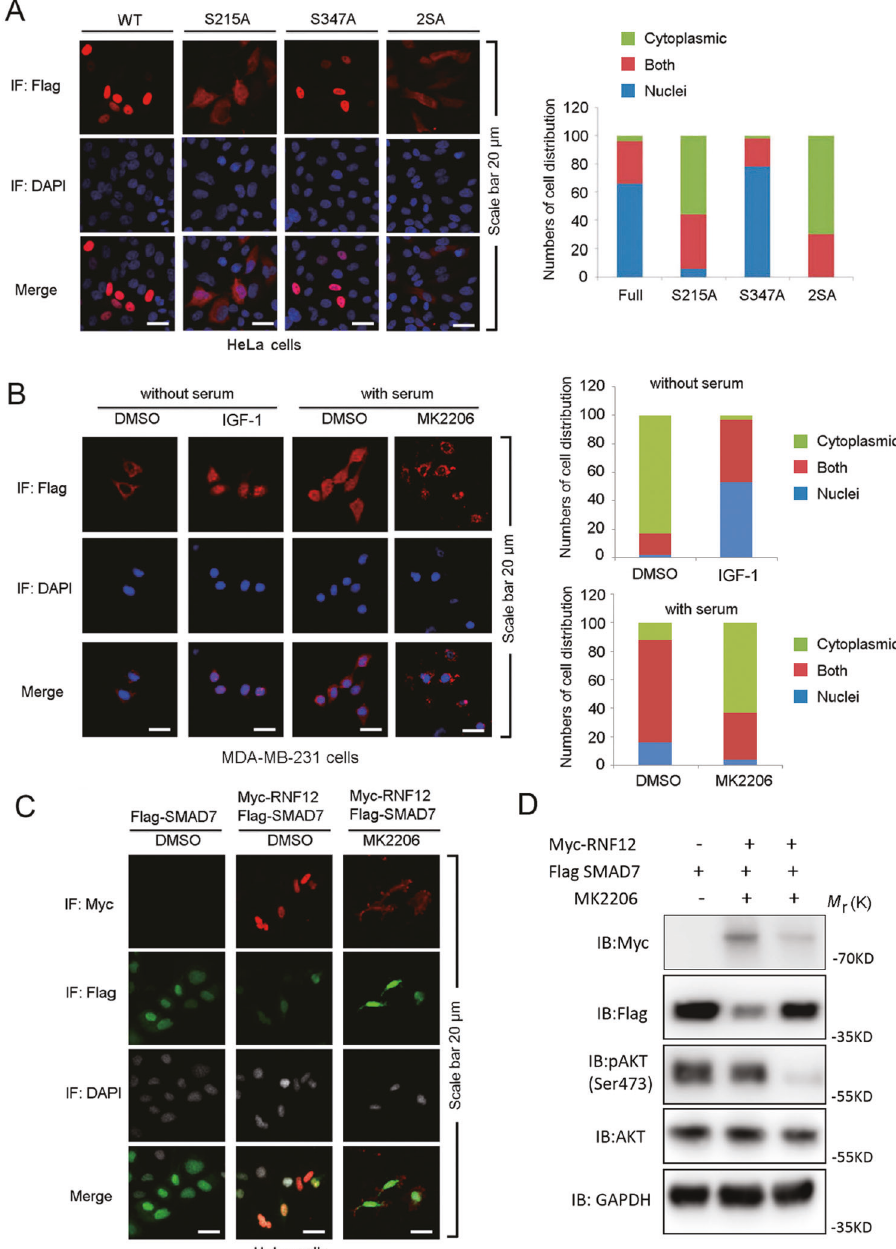
Fig. 4 AKT activation promotes the nucleus localization of RNF12. A Immuno fl uorescence and 4, 6-diamidino-2-phenylindole (DAPI) staining of HeLa cells stably transfected with RNF12 WT, S215A, S347A/T349A, or S215A/S347A plasmids. Left panel: Number of cells (A) were analyzed according to the following subgroups: cytoplasm, nuclear, or at both locations (both). B Immuno fl uorescence and DAPI staining of MDA-MB-231 cells treated with IGF-1 (200 ng/mL) and MK2206 (5 μ M). C Immuno fl uorescence and DAPI staining of HeLa cells transfected with Flag-RNF12 and GFP-SMAD7, treated with DMSO or MK2206 (5 μ M) for 8 h. D Western blotting experiments relevant with C